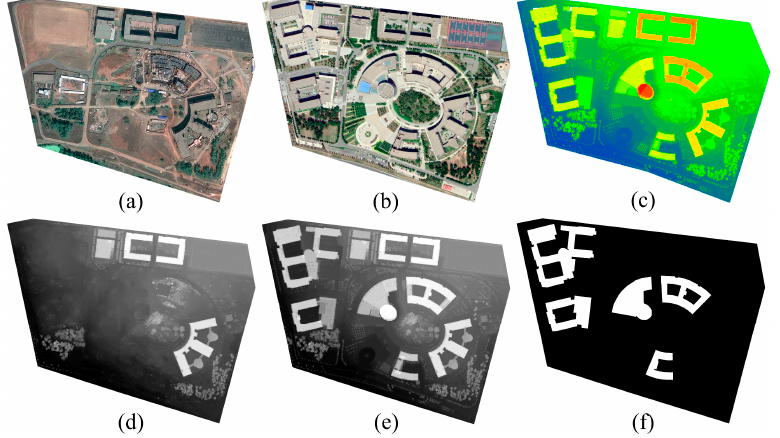
Figure 8. Google Earth image of ( a ) 2009 and ( b ) 2019; ( c ) Point cloud; ( d ) DSM-assumed; ( e ) DSM- original; ( f ) Ground truth, where white indicates changed region and black indicates an un- changed